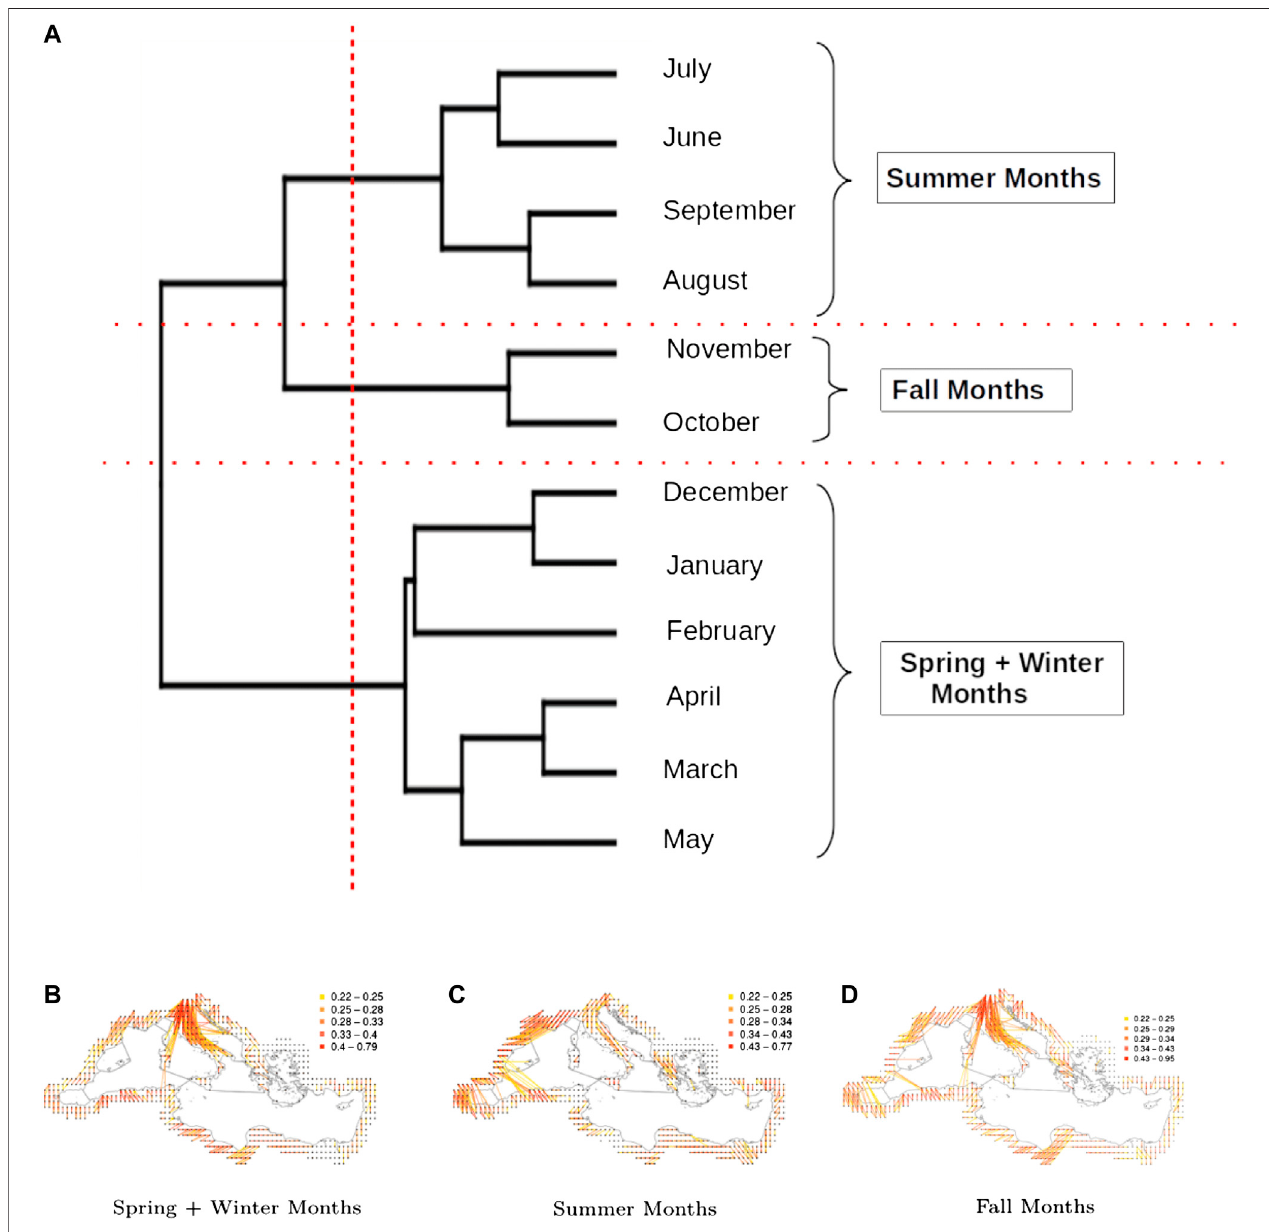
FIGURE 5 | Clustering according to the indices calculated over the Mediterranean spatio-temporal network: (A) : Dendrogram of the months obtained from a hierarchical cluster analysis of the Mediterranean spatio-temporal network based on the monthly dissimilarities of the indices presented in Table 1 . (B) , (C) , and (D) : Networks corresponding to the three identi fi ed